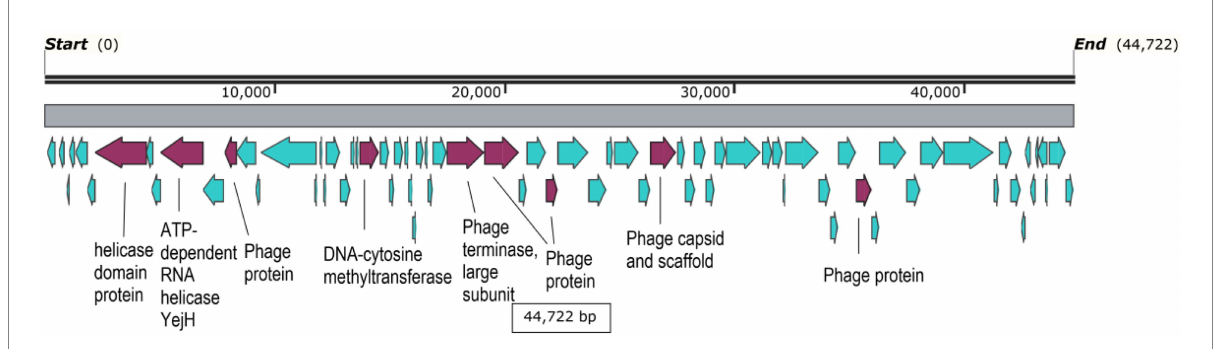
FIGURE 5 Gene map of freshwater_SRR107147.contig000000001. CDS highlighted in cyan are hypothetical proteins, while the purple ones have labeled